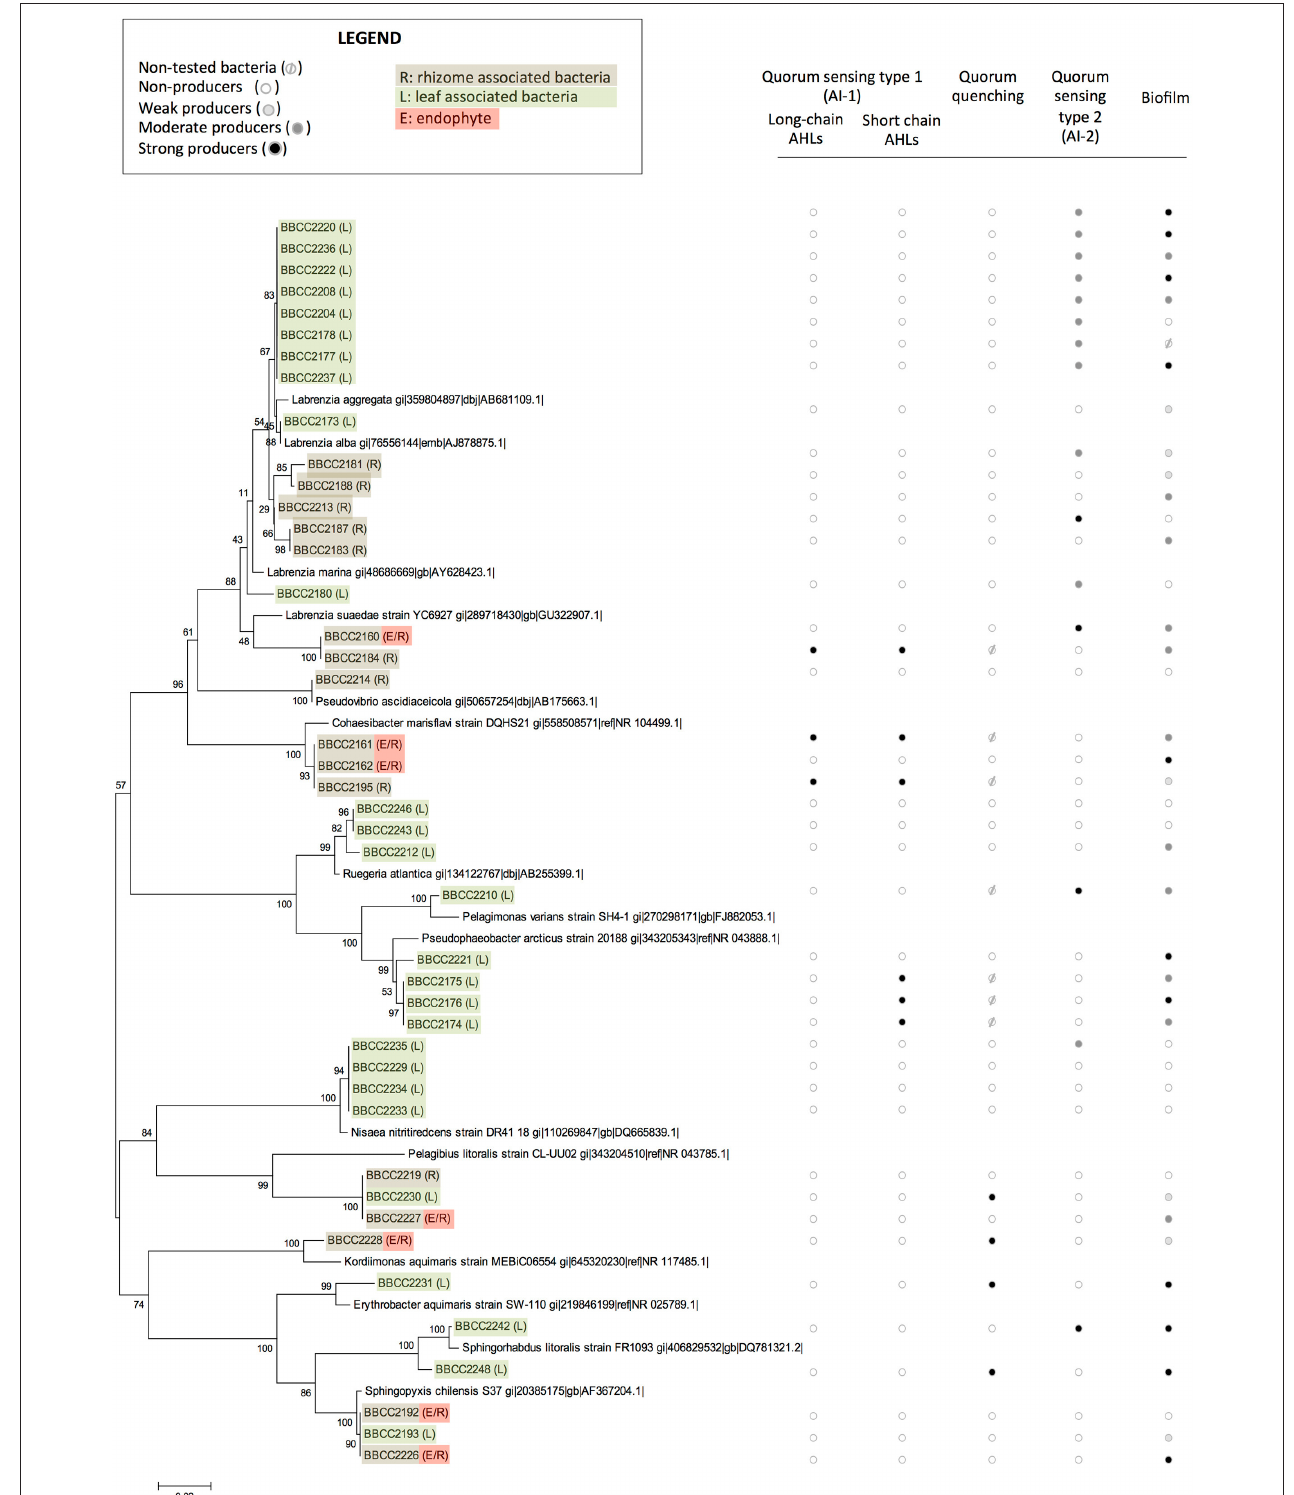
FIGURE 1 | The phylogenetic affiliations of sequences of Alphaproteobacteria -related strains associated with Posidonia oceanica and their abilities to express quorum sensing, quorum quenching, or biofilm formation. The values at each node represent the bootstrap values generated using MEGA 6.0 [Neighbor-joining method with bootstrap (1,000 replications)]. Non-tested bacteria ( ), non-producers ( ), weak producers ( ), moderate producers ( ), and strong producers ( ) R: rhizome associated bacteria, L: leaf associated bacteria, and E: endophyte.